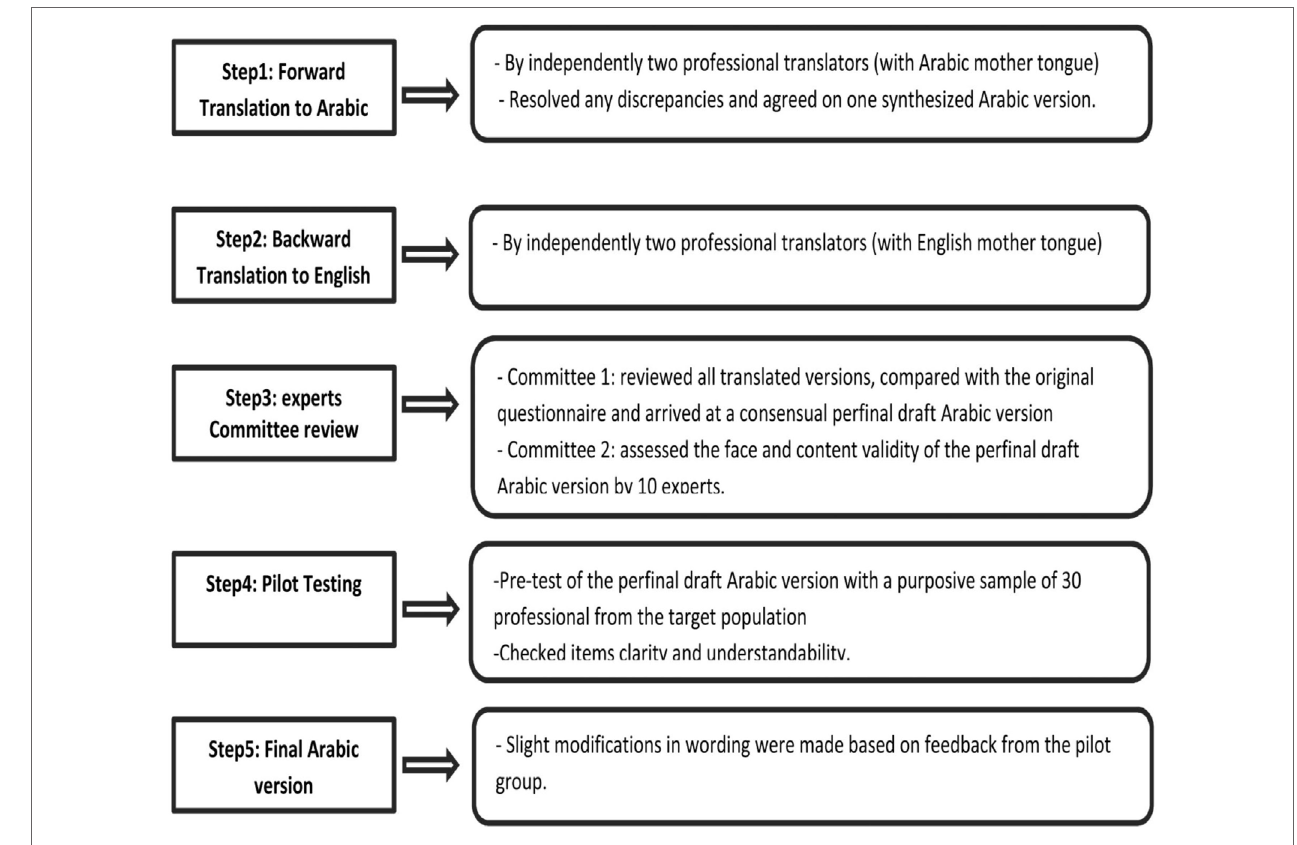
FigUre 1 | The steps of questionnaire